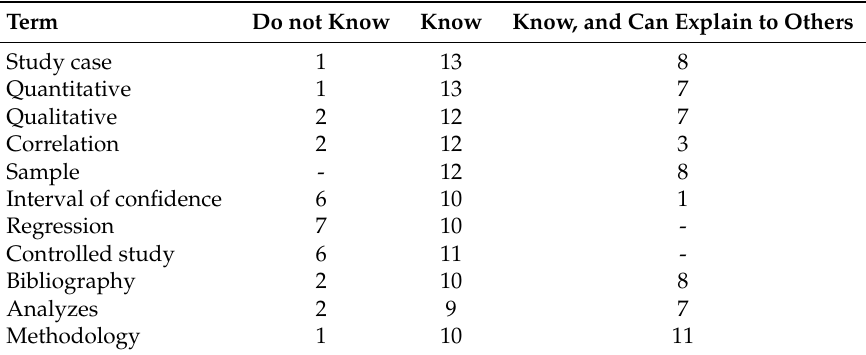
Table 5. Familiarity with research